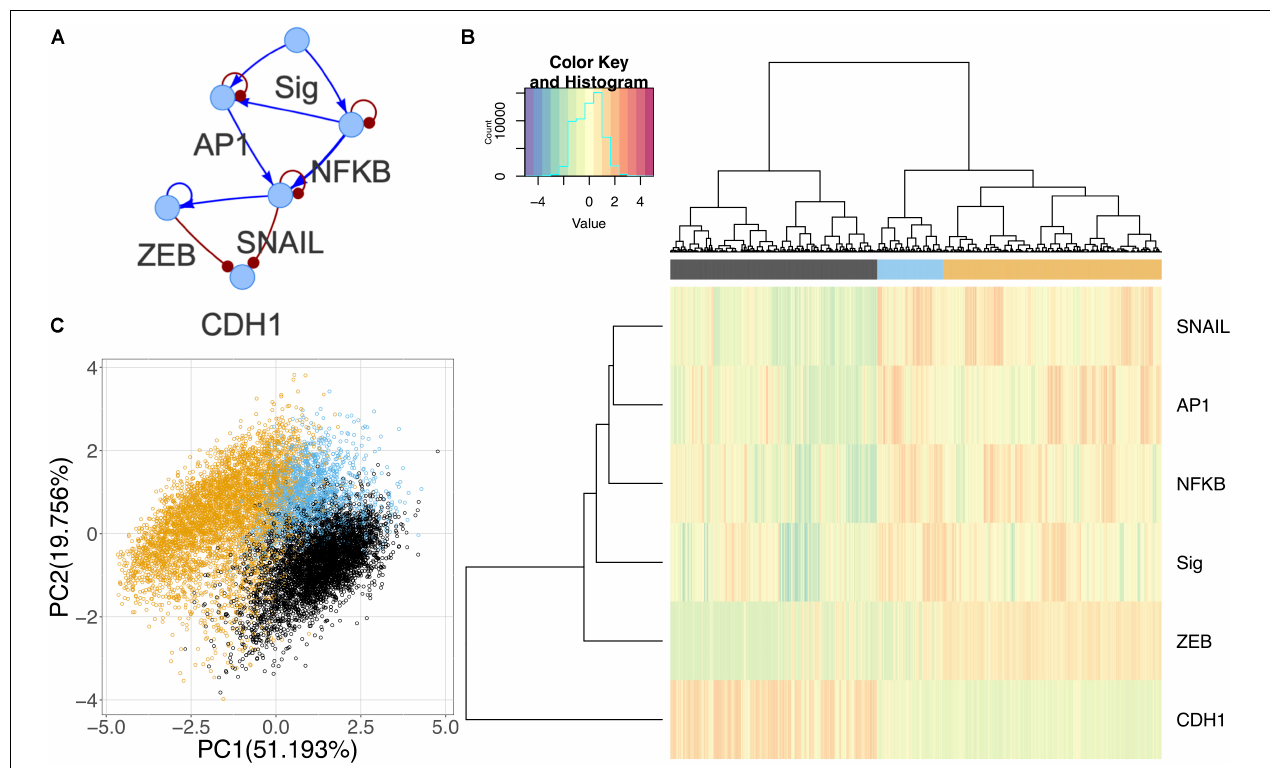
FIGURE 8 | Core network simulations with 2000 RACIPE models. (A) Core EMT network derived from published experimental results. Activating interactions denoted as blue arrows and inhibitory interactions as red round-tipped arrows. (B) Heatmap of core network simulation results with ward.D2 hierarchical clustering of models and genes (number of clusters k = 3). (C) PCA of core network simulation results color coded by